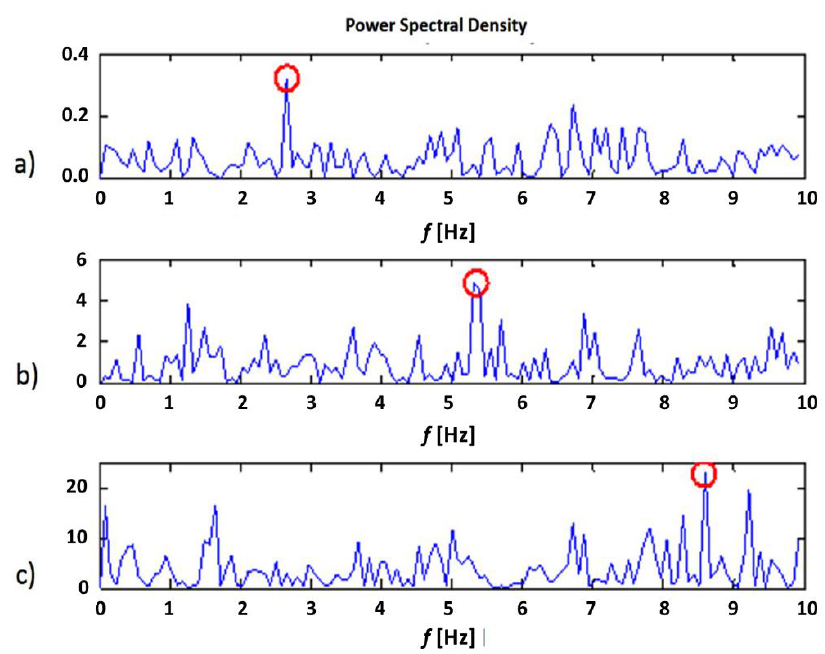
Figure 8. Power spectral density of the EM bias fluctuation (mean removed) for incidence/scattering angle θ ( b ) U = 10 m/s; and ( c ) U 10 R R